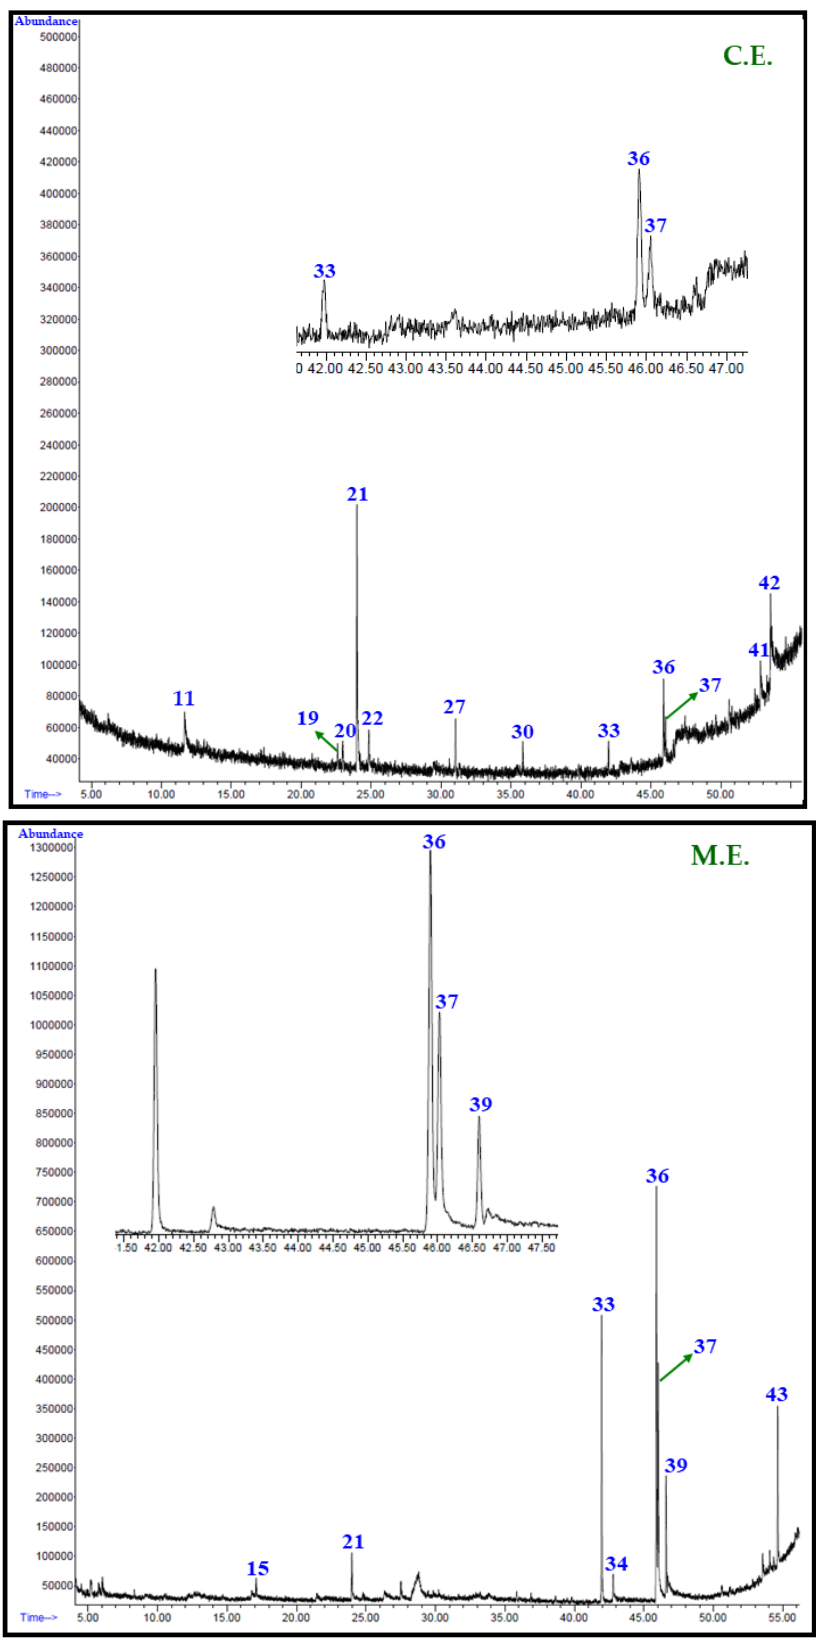
Figure 2. Total ion chromatogram (TIC) of n -hexane (H.E.), chloroform (C.E.), and methanol (M.E.) extracts of C. colocynthis seeds .